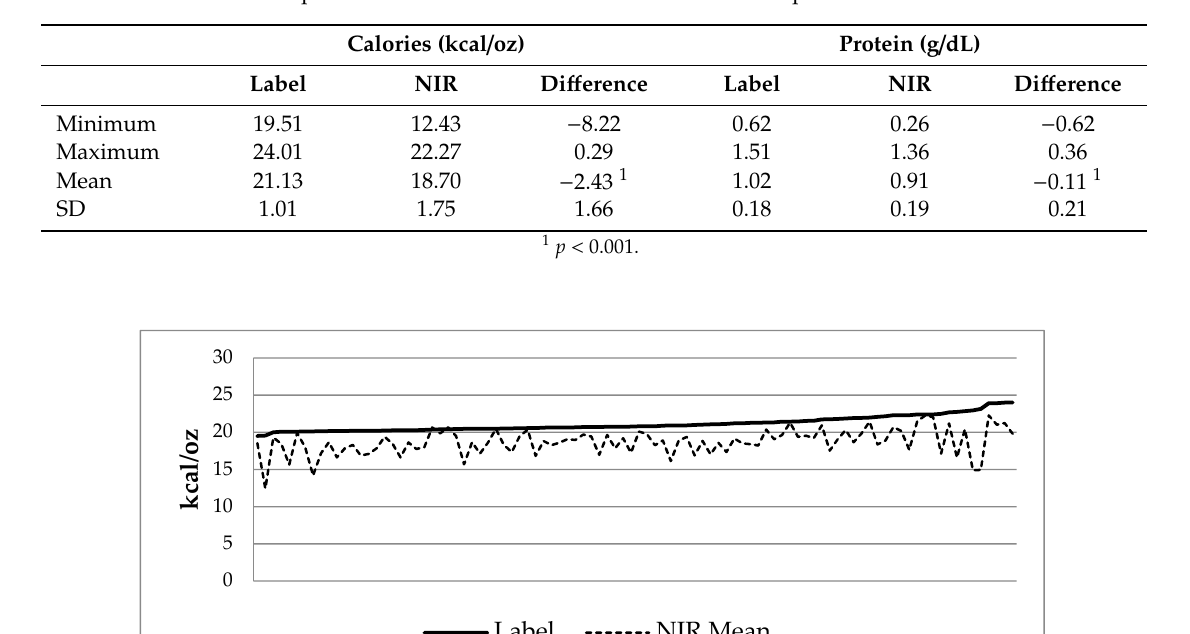
Table 2. Near-infrared (NIR) macronutrient analysis of donor breast milk (DBM) samples ( n = 96).